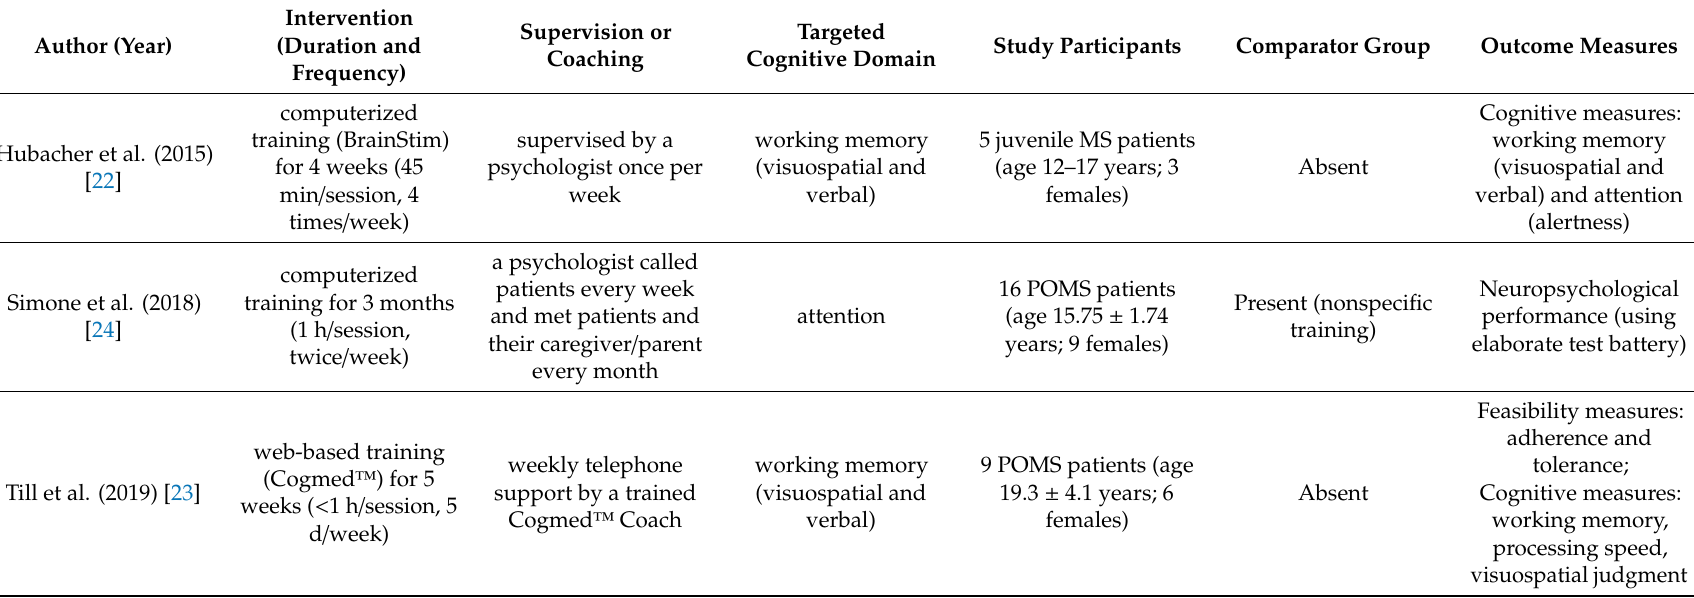
Table 2. Overview of studies evaluating cognitive rehabilitation for POMS: Study